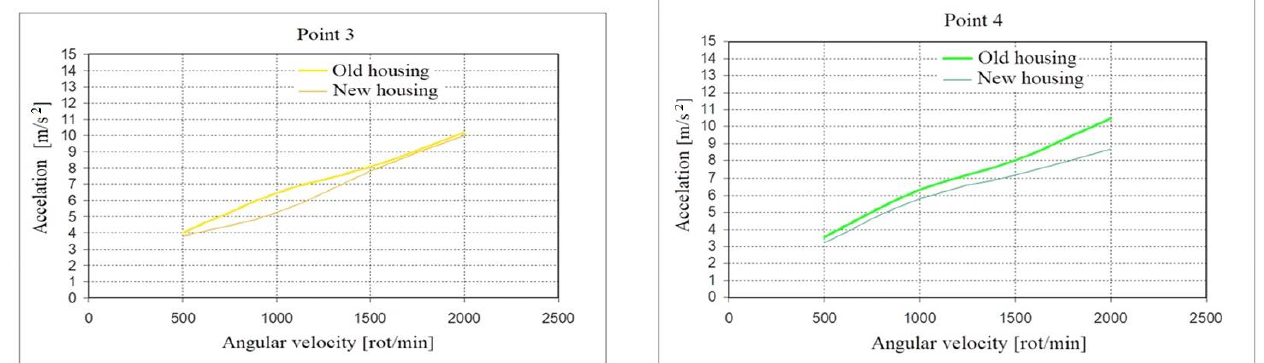
Figure 21. Measured accelerations at points 1 and 2 for the two versions (old and new).